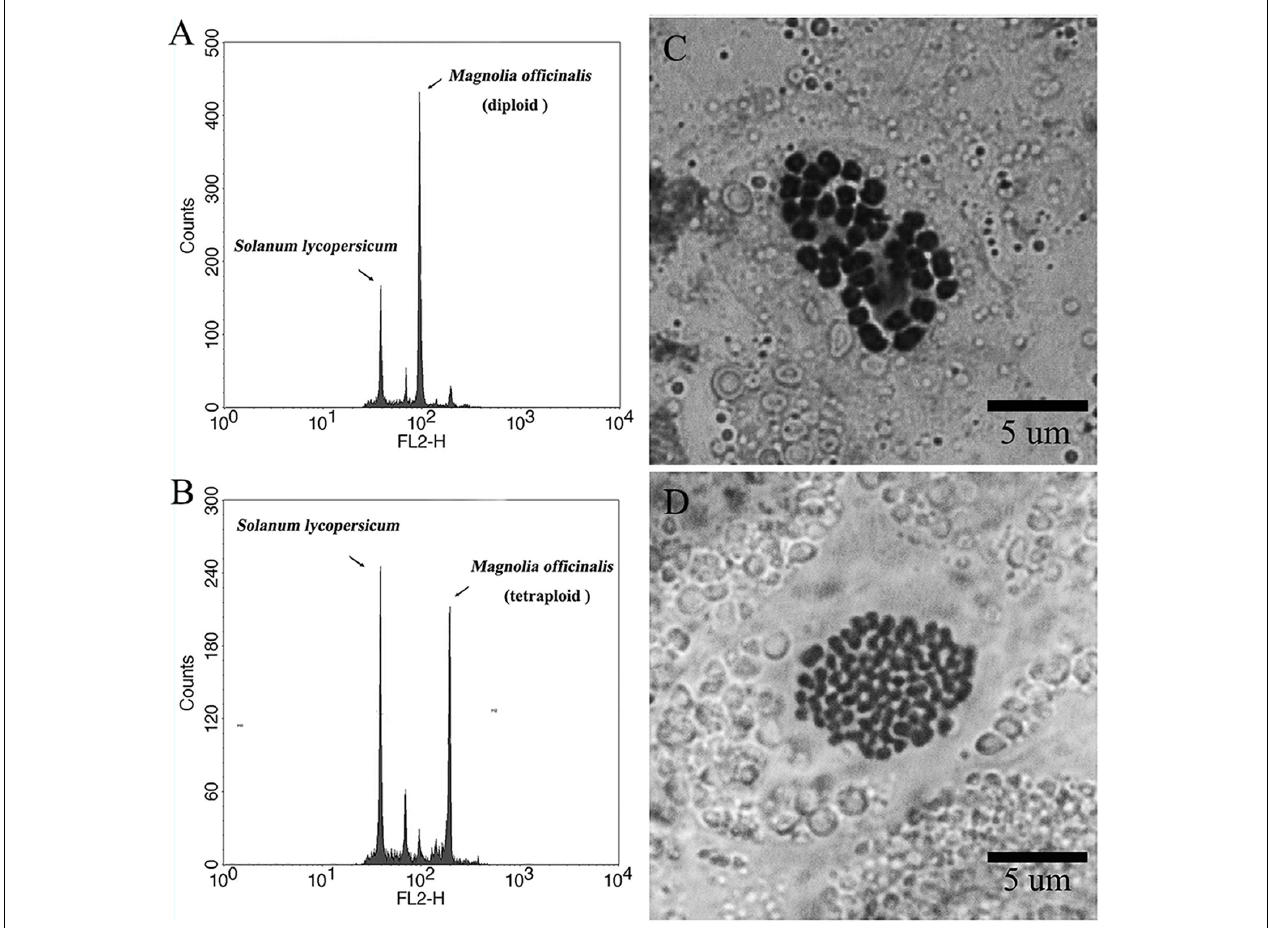
FIGURE 7 | Representative flow cytometry histograms and karyotypes of diploid and tetraploid Magnolia officinalis . Representative flow cytometry histograms of the nuclear DNA content in (A) diploid and (B) tetraploid leaf samples of M. officinalis . Chromosomes prepared from (C) diploid (2 n = 2 × = 38) and (D) tetraploid (2 n = 4 × = 76) samples of M. officinalis